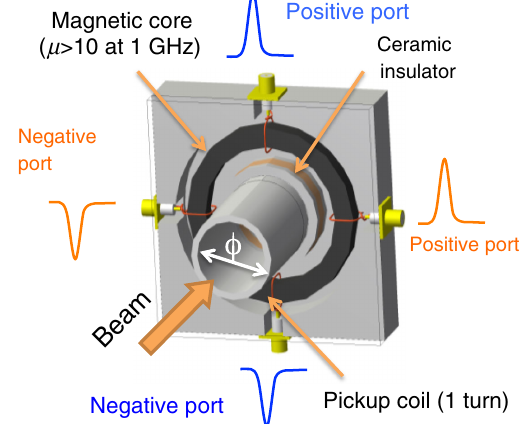
FIG. 12. Schematic drawing with the inside structure of the DCT.